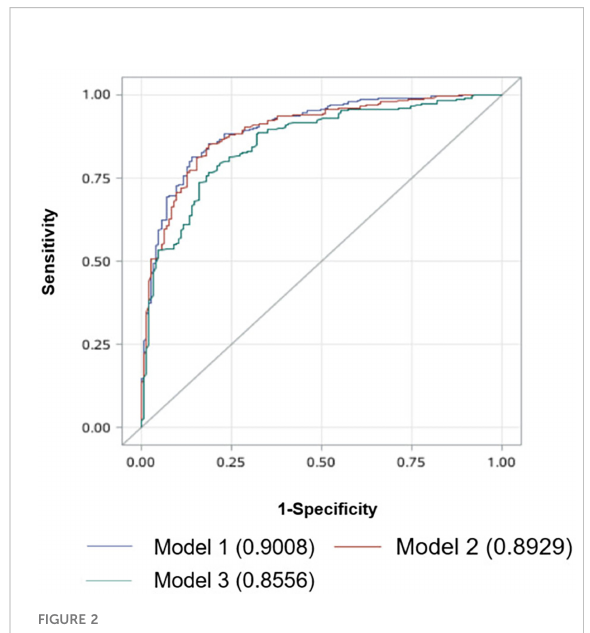
FIGURE 2 Receiver operating characteristic curve analysis for predicting large-volume CCLNM. Model 1: factors include age, gender, CLT, and ultrasound features such as tumor location, tumor size, margin, calci fi cation, and abnormal LNs. The AUC is 0.9008. Model 2: factors include age, gender, and ultrasound features such as tumor location, tumor size, margin, calci fi cation, and abnormal LNs, excluding CLT. The AUC is 0.8929. Model 3: factors include age, gender, and ultrasound features such as tumor location, tumor size, margin, and calci fi cation, excluding CLT and abnormal LNs. The AUC is 0.8556. CCLNM, central cervical lymph node metastasis; CLT, chronic lymphocytic thyroiditis; LNs, lymph nodes; AUC, area under the receiver operating characteristic